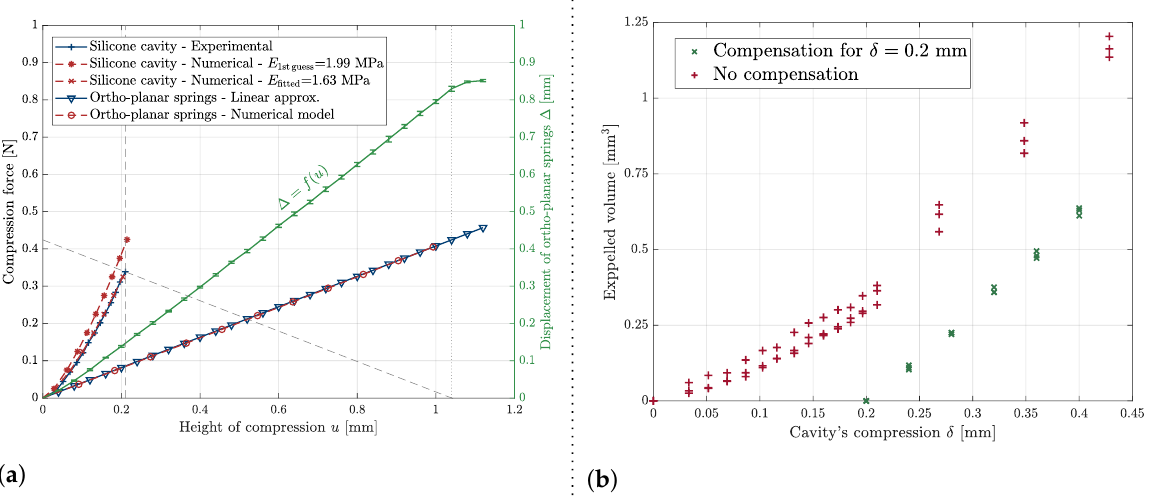
Figure 5. ( a ) Results of the experimental characterization of the cavity. The known stiffnesses of the ortho-planar springs were used to determine the force characteristic of the elastic cavity. This force characteristic was compared with the solution of a finite element model (presented in Appendix A.2). ( b ) Expelled volume as a function of the cavity’s compression δ . The figure shows the expelled volume for no compensation of the parasitic compression before the stops were reached and with